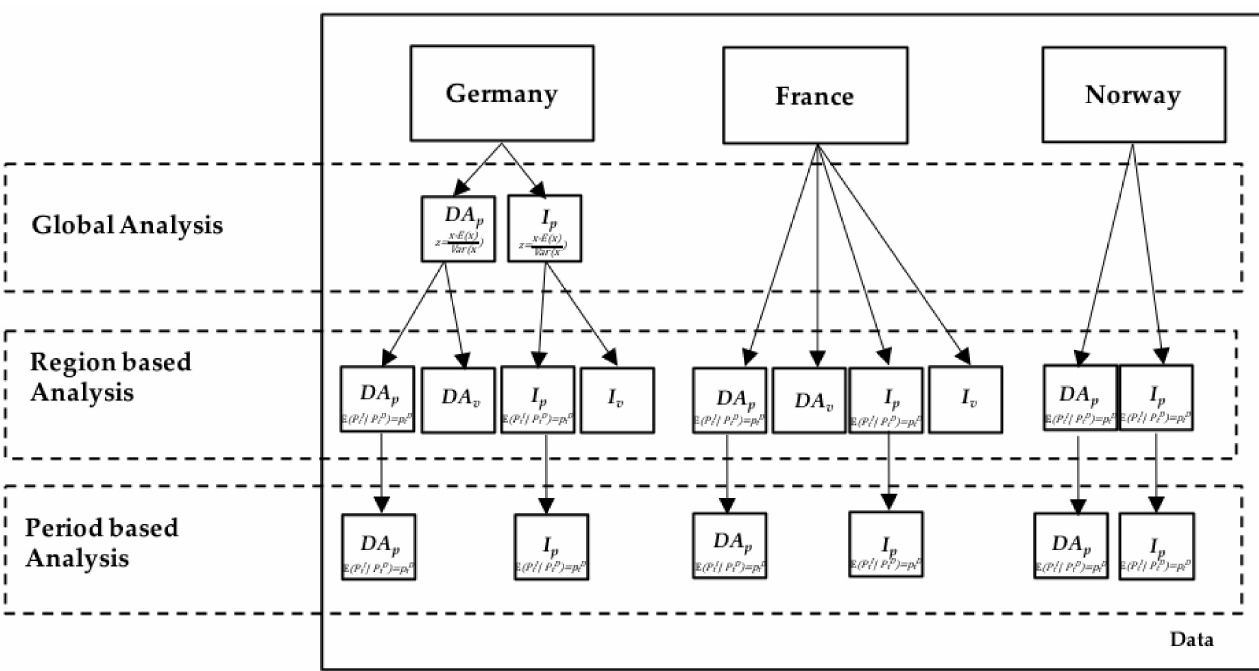
Figure 2. This figure represents the research design including the different stages of research the data went through in the course of the analysis. The extent at which each kind of data got analyzed has been linked to the data availability in Bloomberg. DA = day-ahead, I = intraday, p = Price, v =